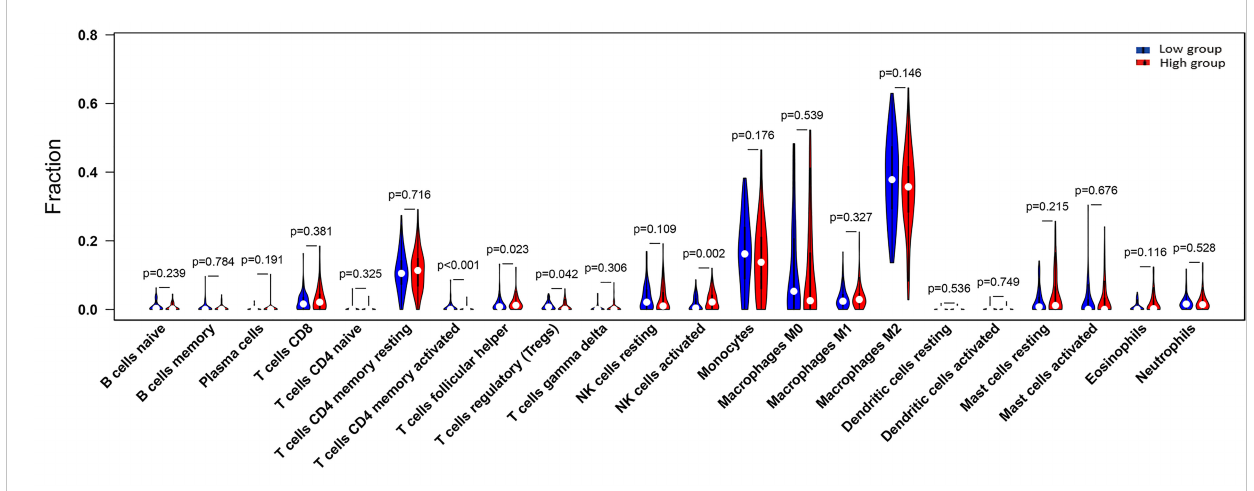
FIGURE 4 The proportion of 22 subpopulations of immune cells (T cells CD4 memory activated, T cells follicular helper, T cells regulatory (Tregs) and NK cells activated are main immune cells effected by GRN expression. Among them, T cells CD4 memory activated (p <0.001), T cells regulatory (Tregs) (p = 0.042) are decreased in high expression group compared with low expression group. In contrast, T cells follicular helper (p = 0.023), NK cells activated (p = 0.002) are increased in high expression group compared with low expression group; the blue is low GRN expression group and the red is high GRN expression group).